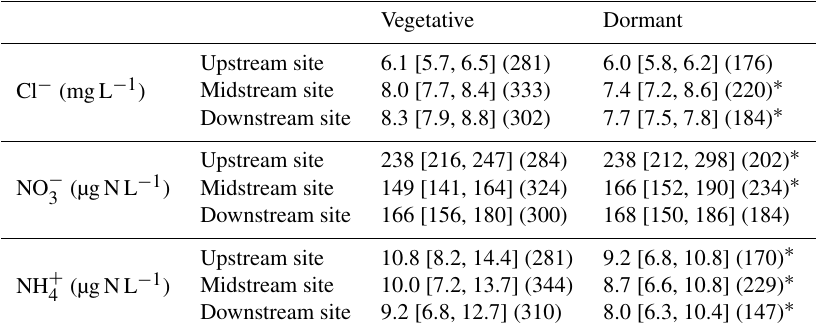
Table 3. Median and interquartile range [25th, 75th] of stream solute concentrations at each sampling site for the vegetative and dormant periods. The number of cases is shown in parentheses for each group. The asterisks indicate statistically significant differences between the two periods (Wilcoxon rank sum test, ∗ p < 0.01).